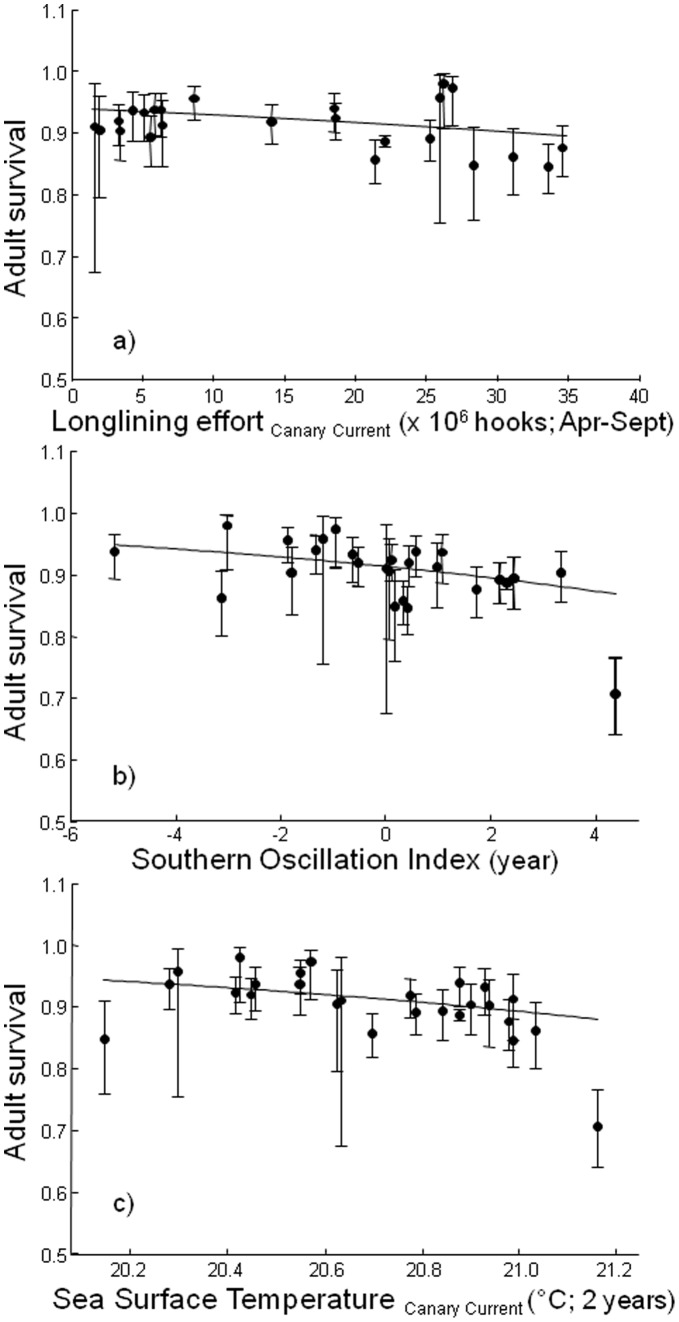
Relationship between annual adult survival probabilities and the selected covariates from the best CMR model.(a) Longlining effort in the Canary Current during the breeding, (b) annual SOI and (c) SST in the Canary Current (2 years averaged) are depicted against survival estimates (mean in black dots and asymmetric CI in solid bars estimated from the model Φt pm+t). Regression lines estimated from model 24 in Table 3.